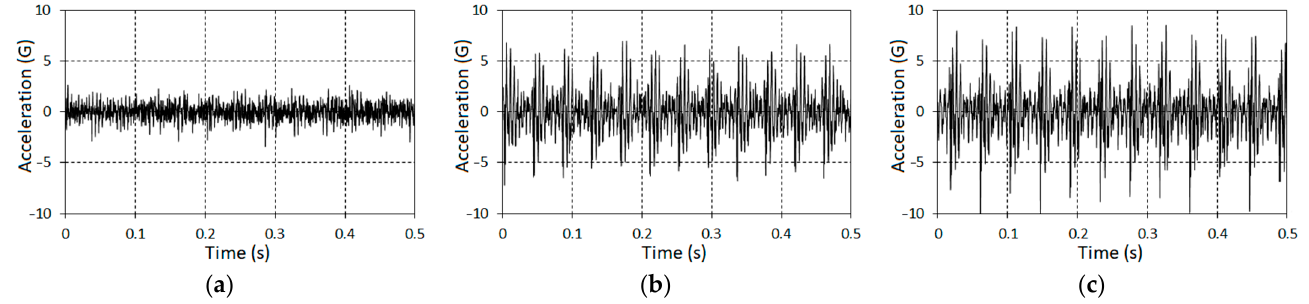
Figure 2. The segments of vibration realizations for three ( a – c ) stages of tooth failure.